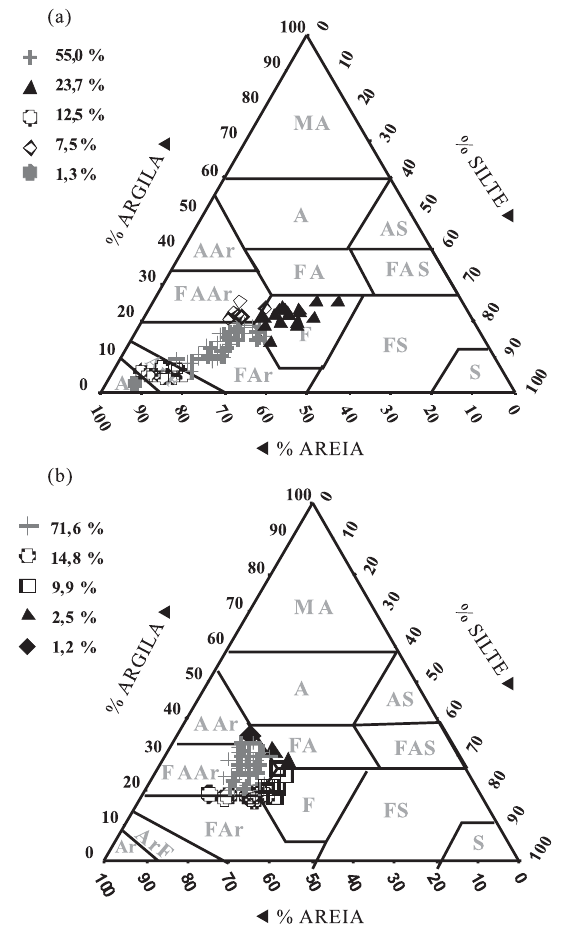
Figura 1. Classes texturais dominantes dos dois solos: Neossolo Flúvico (a) e Latossolo Amarelo (b). Ar: